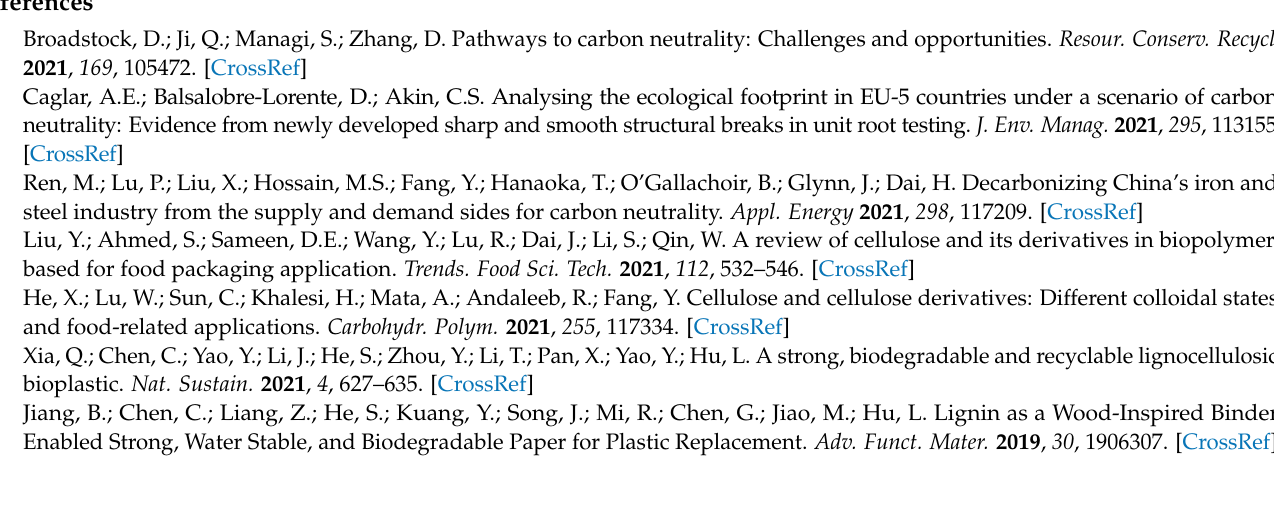
PE film; Figure S4: The FTIR spectrum of commercial PE film; Figure S5: The (a) TG and (b) DTG curve of commercial PE film; Figure S6: The stress-strain curve of commercial PE film; Figure S7: The water contact angle (WCA) of commercial PE film; Table S1: The thicknesses of the C-film, H-film and